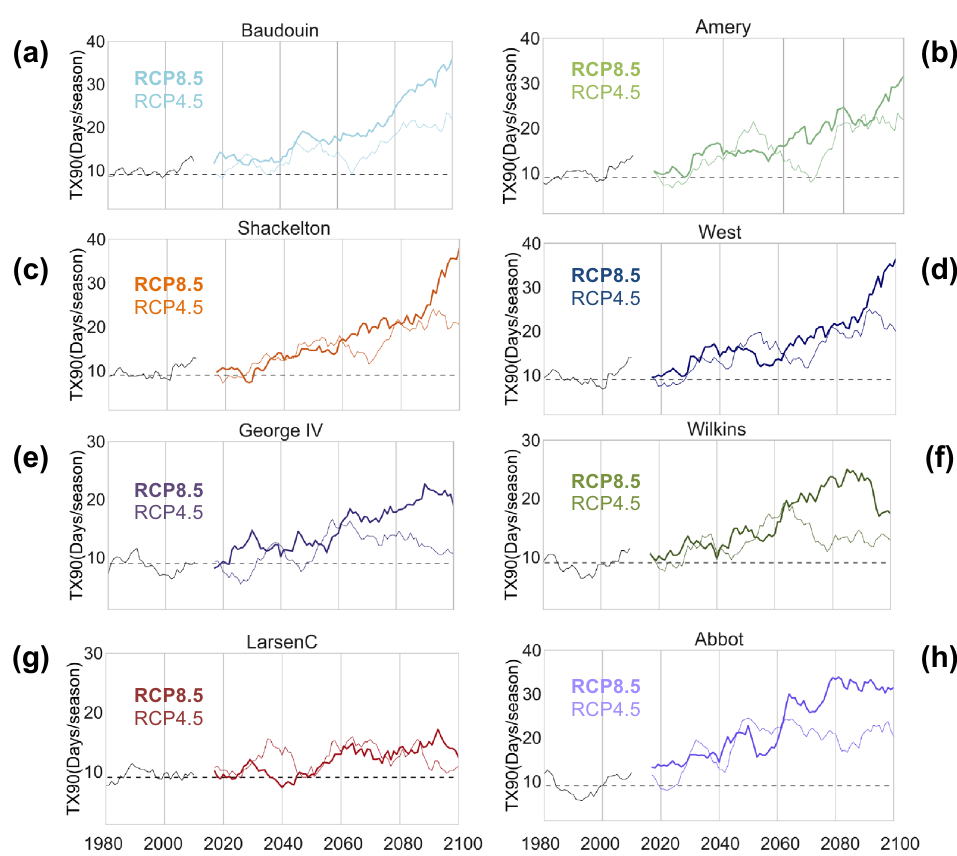
Figure 4. Summer very warm days will surge on most of the Antarctic Ice shelves. 10-year centered moving averages of “very warm” DJF days (TX90) expected under the RCP4.5 scenario (thin lines) and under the RCP8.5 scenario (bold lines) for selected ice shelves: Baudouin ( a ), Amery ( b ), Shackleton ( c ), West ( d ), George VI ( e ), Wilkins ( f ), Larsen C ( g ) and Abbot ( h ). Time series corresponding to Ross, Ronne, and Amery are shown in the Supplementary Information. RACMO2 simulations were used (see “Methods” section). Plots were generated by using Python’s Matplotlib Library 44